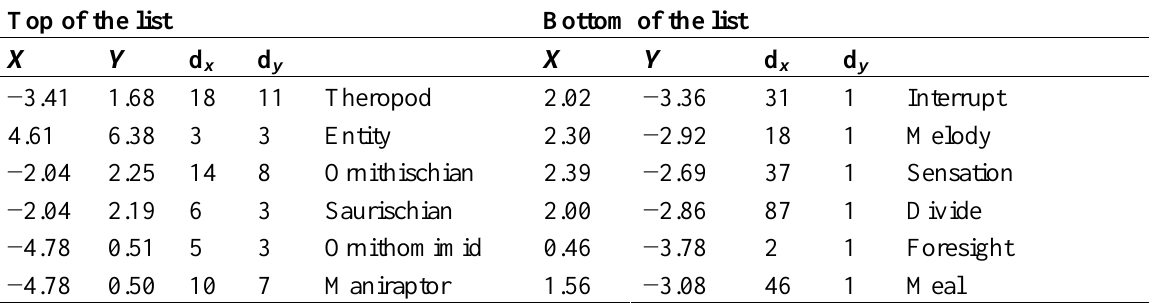
Table 6. “Outliers”: words sorted by the difference of scaled coordinates in Figure 5 (the distribution is “sliced” by lines parallel to the red line in Figure 5). Two ends of the list are shown in the left and right columns. X and Y are map coordinates on the map constructed from words and from senses respectively; d x and d y are the corresponding degrees of graph nodes. Top of the list Bottom of the